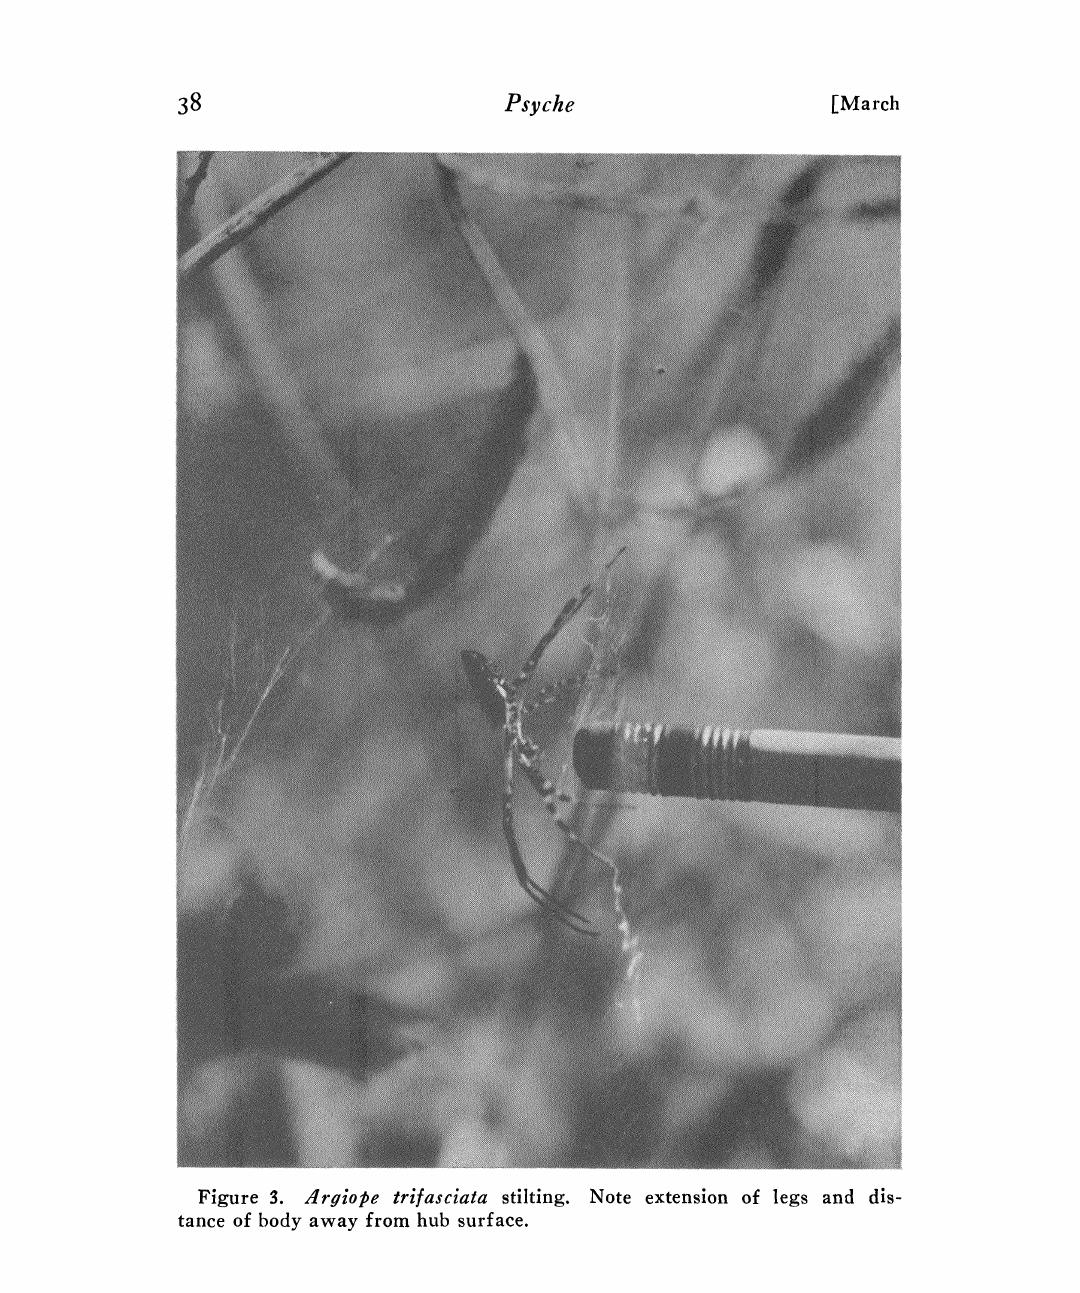
Figure 3. lrTiope trifasciata stilting. Note extension of legs and dis- tance of body away from hub